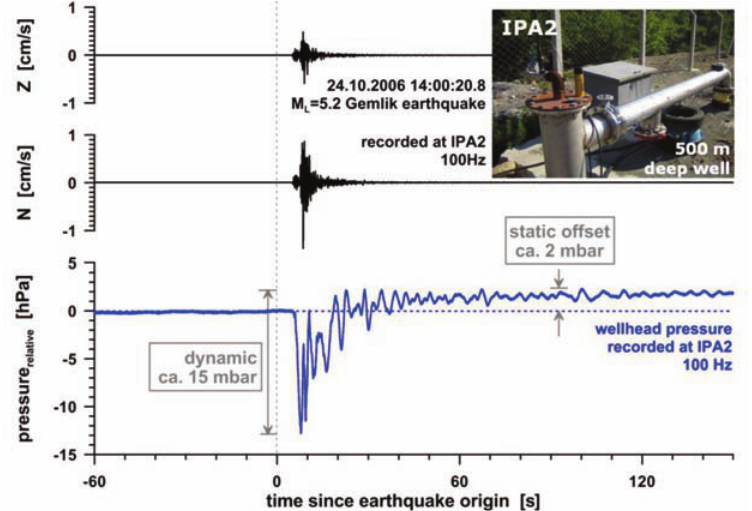
Figure 9. An example of the dynamic and static pressure changes in a well recorded for the thermal field of Armutlu after the M